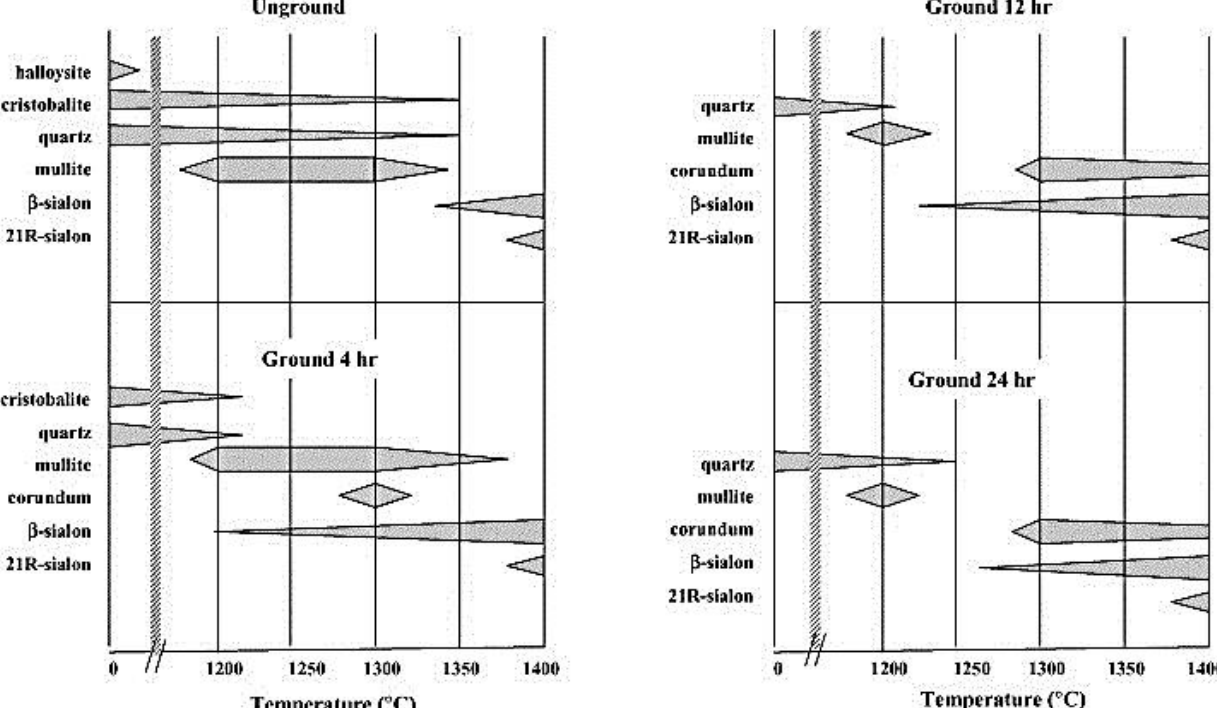
Figure 8. Schematic representation of the crystalline phases formed from the ground and unground CRN precursors in Figure 1.